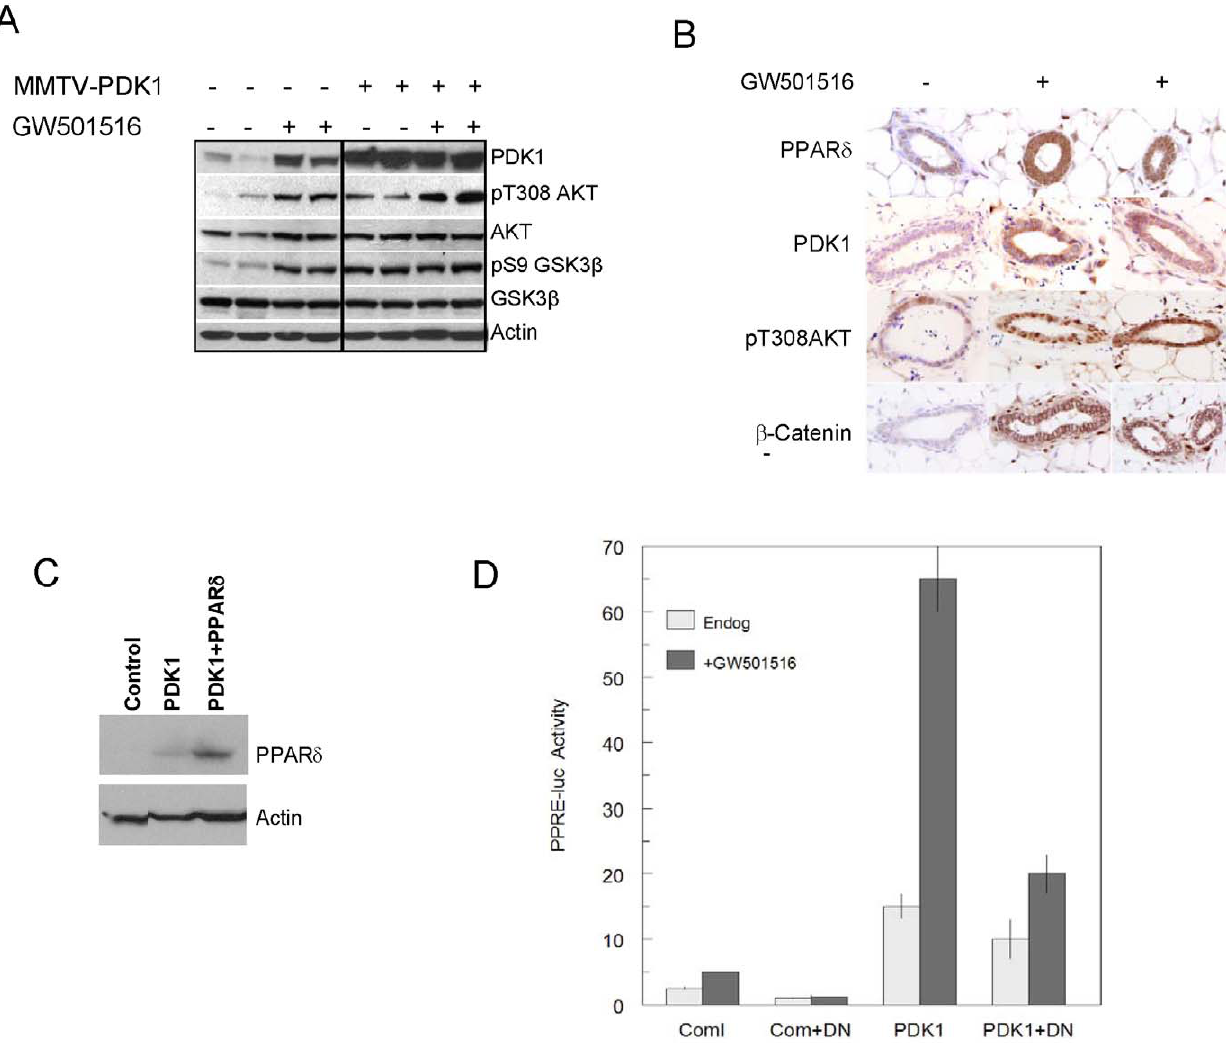
Figure 3. GW501516 increases PDK1, pT308AKT, PPAR d and b -catenin expression in the mammary gland. (A) Immunoblot analysis of mammary gland lysates from a wild-type ( WT ) and two MMTV-PDK1 ( PDK1 ) mice maintained on either standard ( 2 ) or GW501516-supplemented ( + ) diets. The results indicate that GW501516 increased PDK1 and pT308AKT in both groups, and pS9GSK3 b in wild-type mice. (B) IHC analysis indicates that PDK1, pT308AKT, PPAR d and b -catenin were preferentially increased in wild-type mice following GW501516 treatment. Magnification 600 6 . (C) Comma-1D mammary epithelial cells transduced with either empty virus ( Contro l) or PDK1-expressing virus ( PDK1 ), and assessed for PPAR d expression by western blotting. PDK1 cells transfected with PPAR d (PDK1 + PPAR d ) served as a positive control. PPAR d expression was increased in PDK1 cells. (D) Cells in (C) were examined for PPAR d -dependent reporter gene activity in the presence and absence of GW501516 and dominant- negative PPAR d ( DN-PPAR d ). PPAR d -dependent was increased . 10-fold in PDK1-expressing cells vs. control cells, and activity was suppressed by DN- PPAR d .